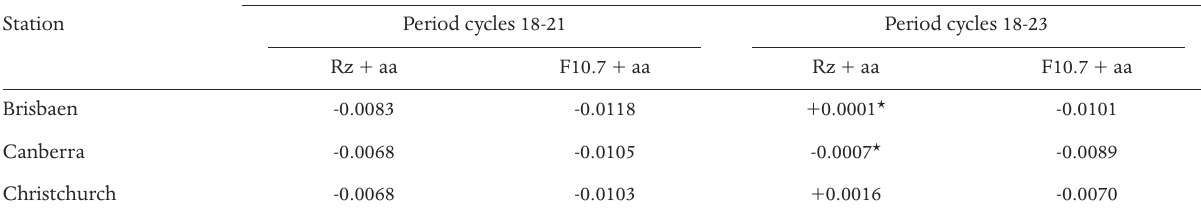
Table 2. foF2 trend in MHz/year calculated for four different conditions: filtering seasonal and solar activity effects using Rz and aa (4th and 6th columns) and F10.7 and aa (5th and 7th columns), and for periods covering solar cycles 18 to 21 (4th and 5th columns) and 18 to 23 (6th and 7th columns) (values with * mean not significantly different from